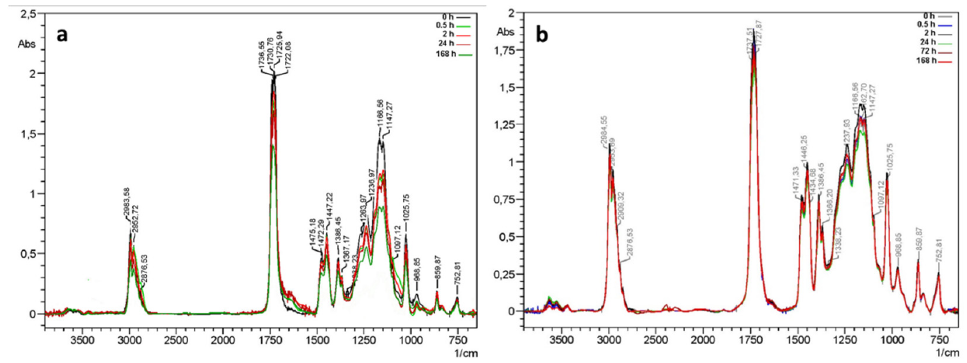
Figure 1. FTIR spectra of ( a ) PB72 + PARNASOS and ( b ) PB72 at various time of exposure.